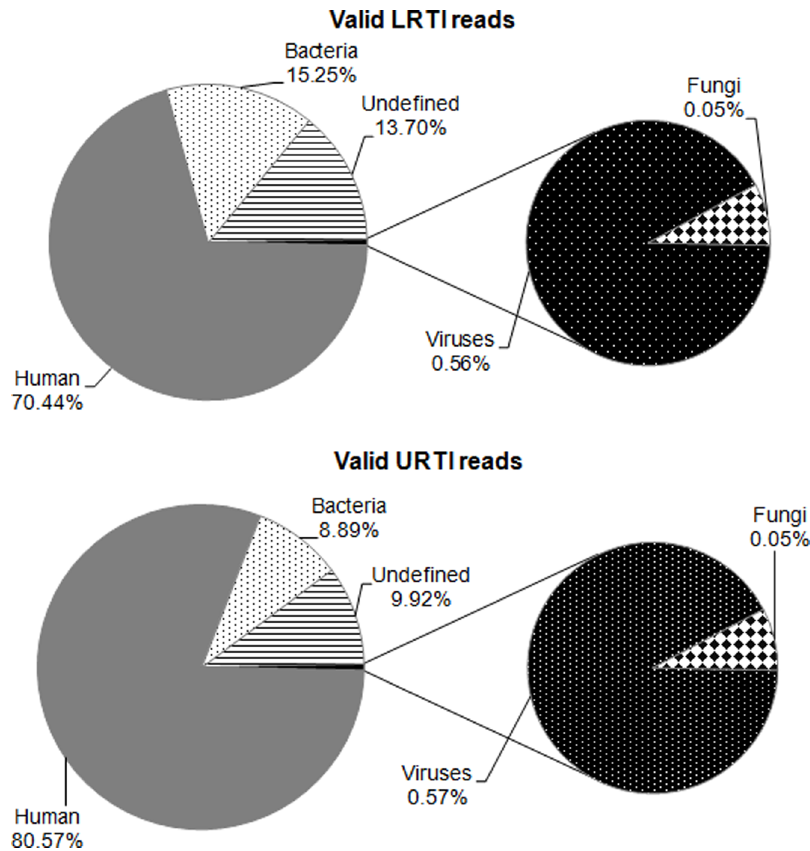
Figure 1. Taxonomic classification of the generated DNA sequencing reads. Valid DNA reads obtained by NGS of LRTI and URTI clinical samples were split into human, bacterial, fungal, and viral origin. Those reads not present in the four previous categories were classified as "undefined". Average values for all LRTI and URTI samples are shown.